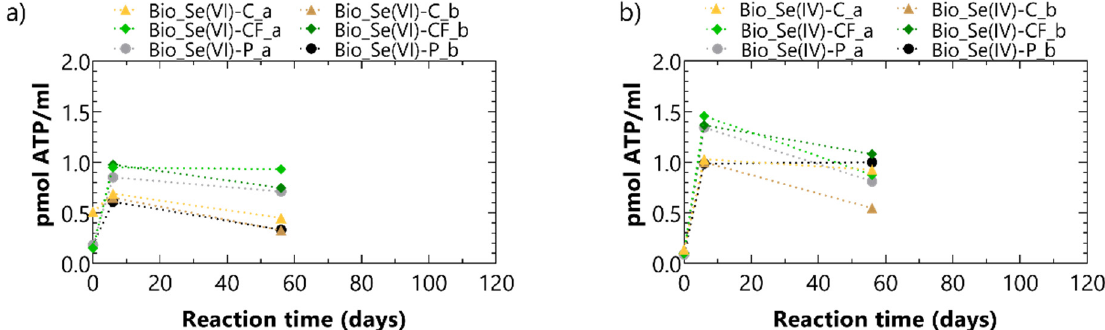
Figure 5. Intracellular ATP measurements for samples in the presence of ( a ) Na 2 SeO 4 or ( b ) Na 2 SeO 3 during the biotic test. Details on the test conditions can be found in the legend and in Table 2.